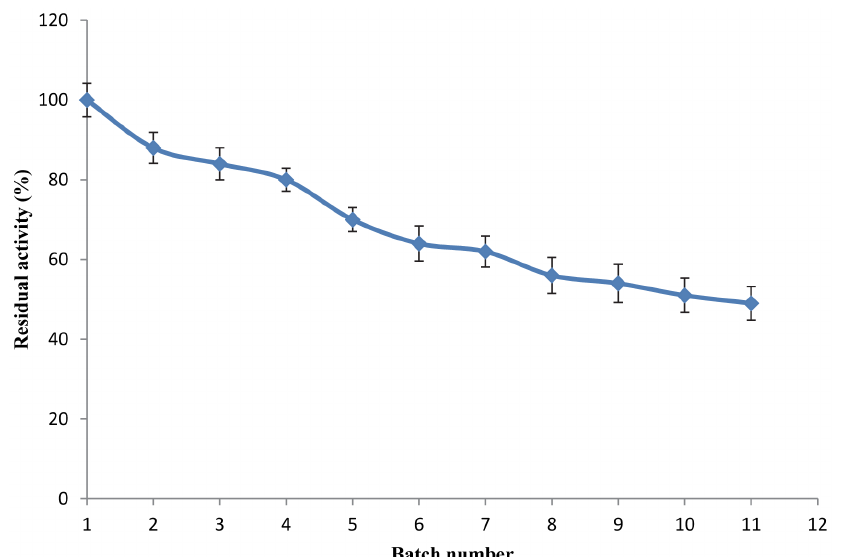
Figure 8. Reusability study of the immobilised lipase. Footnote: The lipolytic activity was determined following the method of Winkler and Stuckmann [21], using p-NP palmitate as substrate. Bars indicate the standard deviation from triplicate determinations. Residual activity of immobilised enzyme at different cycles. 1 cycle=100 6 4.2; 2 cycle=88 6 3.9; 3 cycle=84 6 4.0; 4 cycle=80 6 2.9; 5 cycle=70 6 3.0; 6 cycle=64 6 4.4; 7 cycle=62 6 3.9; 8 cycle=56 6 4.5; 9 cycle=54 6 4.8; 10 cycle=51 6 4.3; 11 cycle=49 6 4.2.